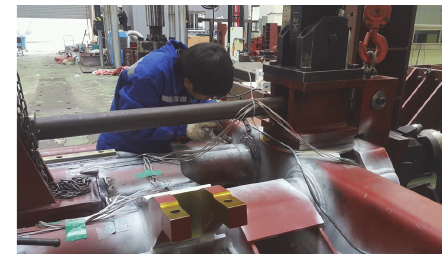
Figure 9: Nondestructive testing after fatigue